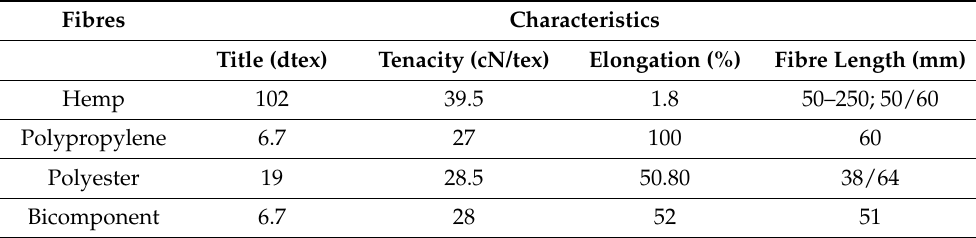
Table 1. Characteristics of the fibres used to obtain composites.